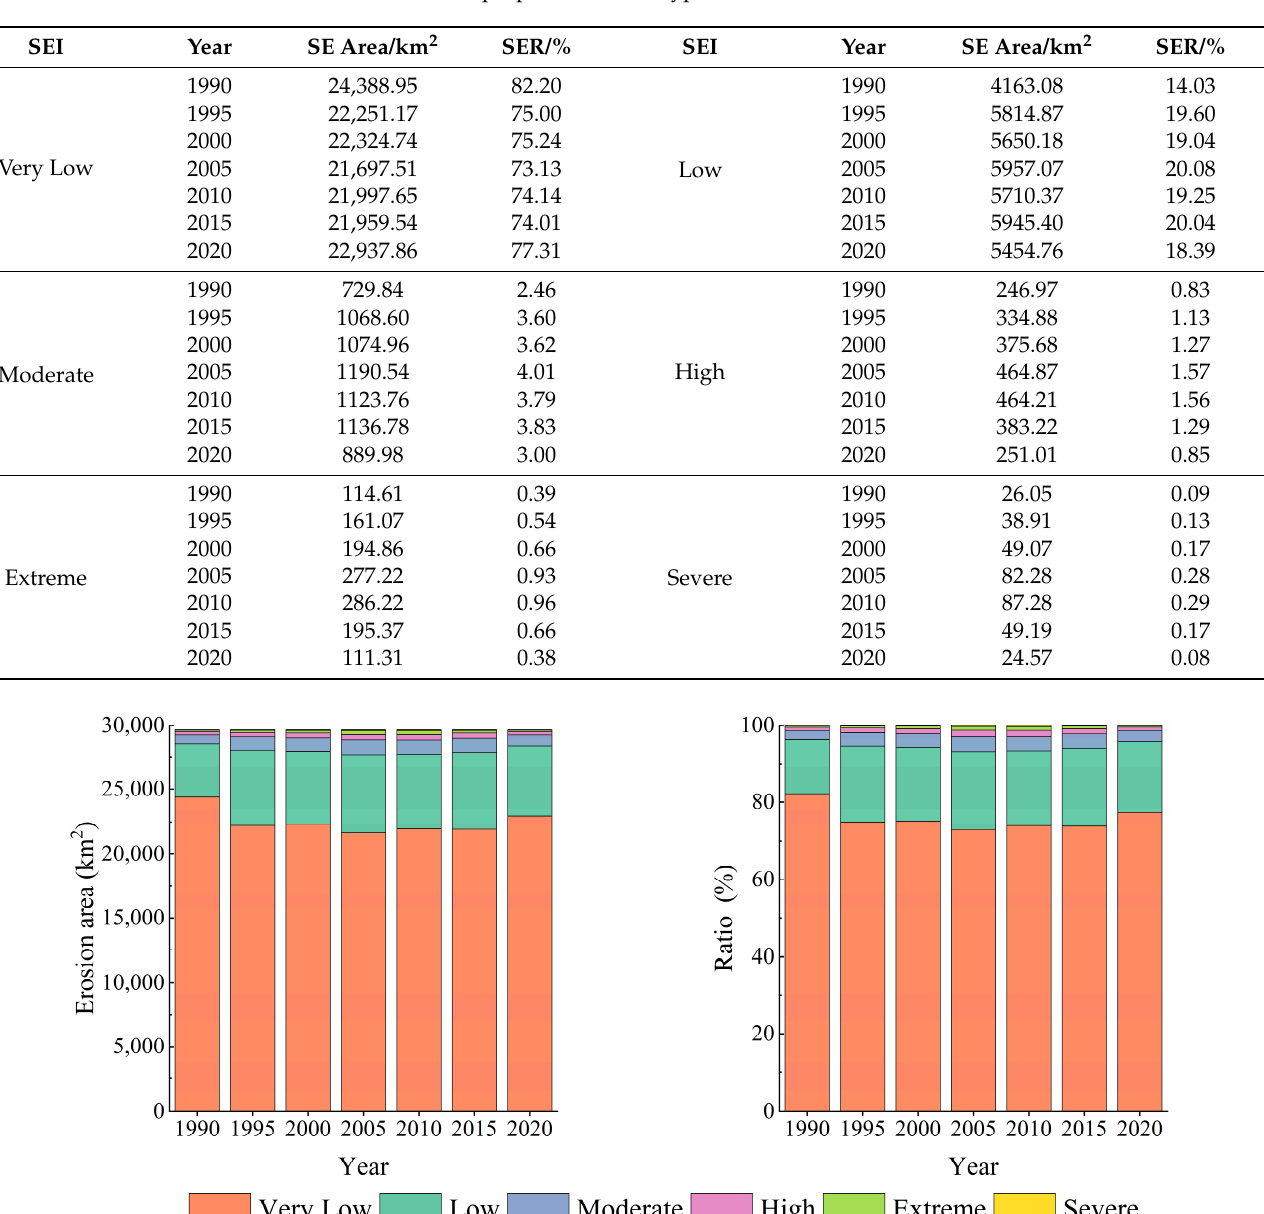
Table 3. Areas and proportions of six types of SE in the QLB from 1990 to 2020.